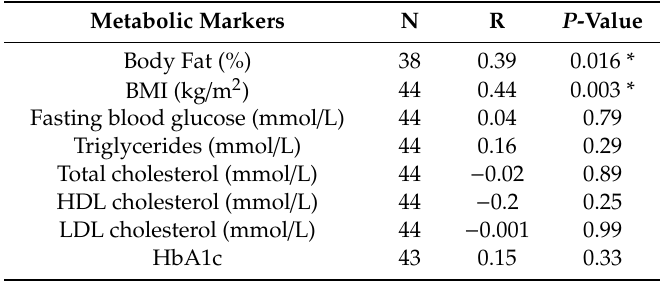
Table 1. Association of adipose tissue IL-8 with metabolic markers in humans.